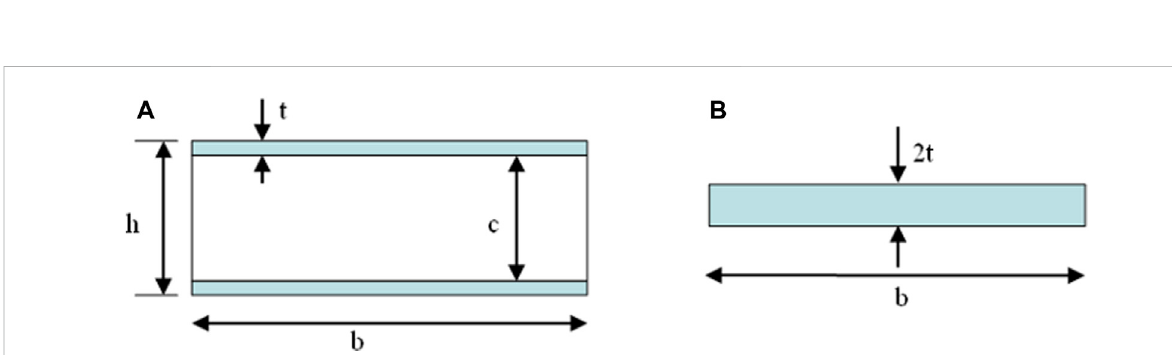
The fl exural stiffness for the isotropic foam core sandwich composite is given by: